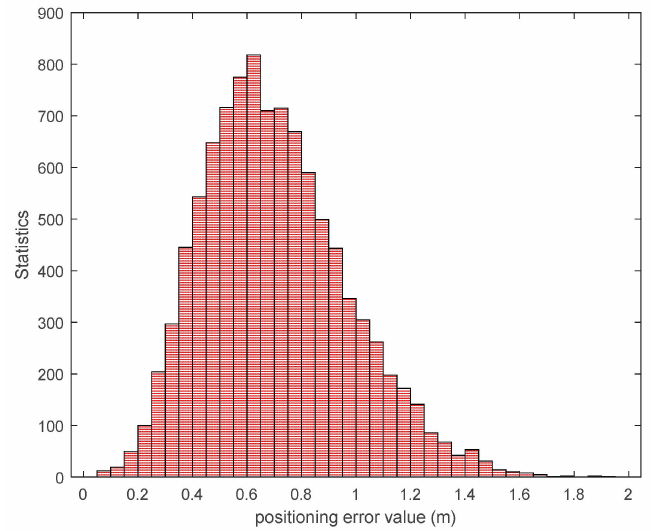
Figure 19. Probability statistics of positioning accuracy for multiple positioning